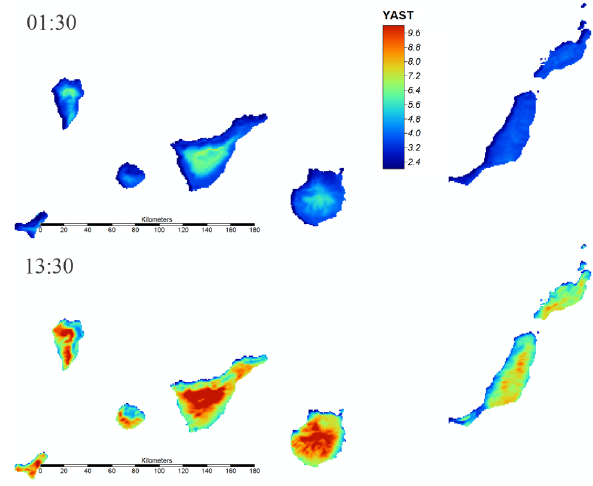
Figure 4. Mean annual surface temperature (MAST) in K at 13:30 (upper) and 1:30 (lower) overpass time.